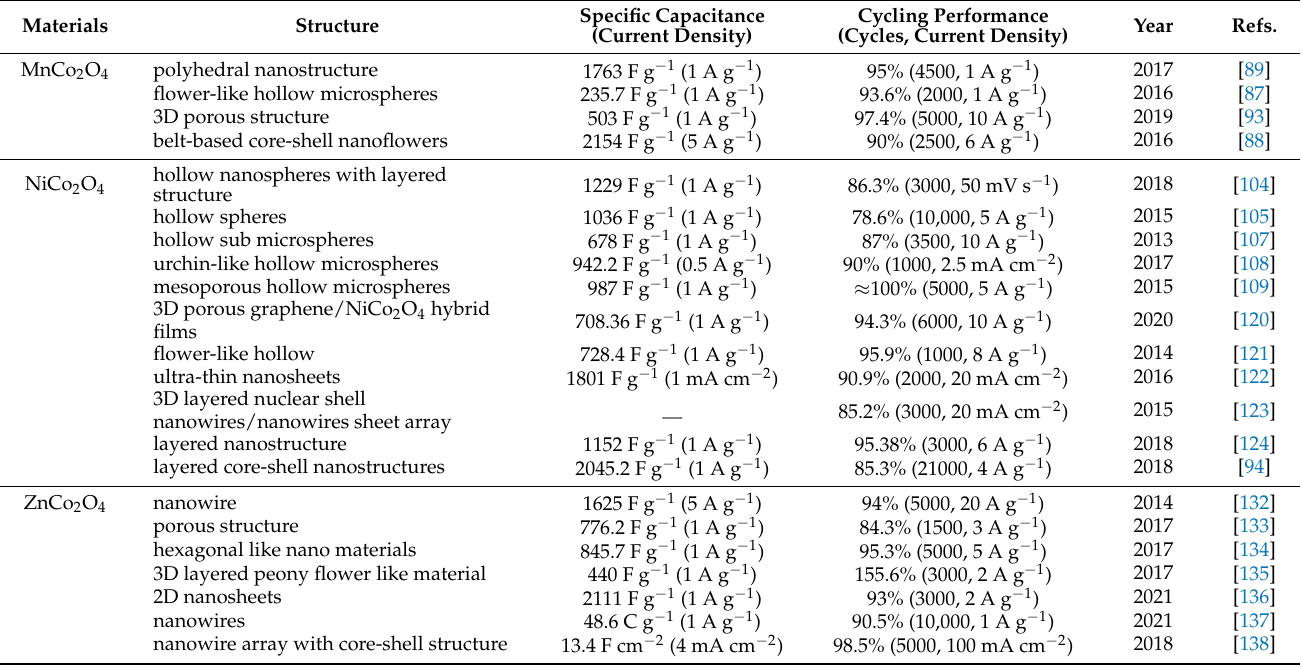
Table 2. Summary of materials, structures, and electrochemical properties of cobalt-containing ternary metal